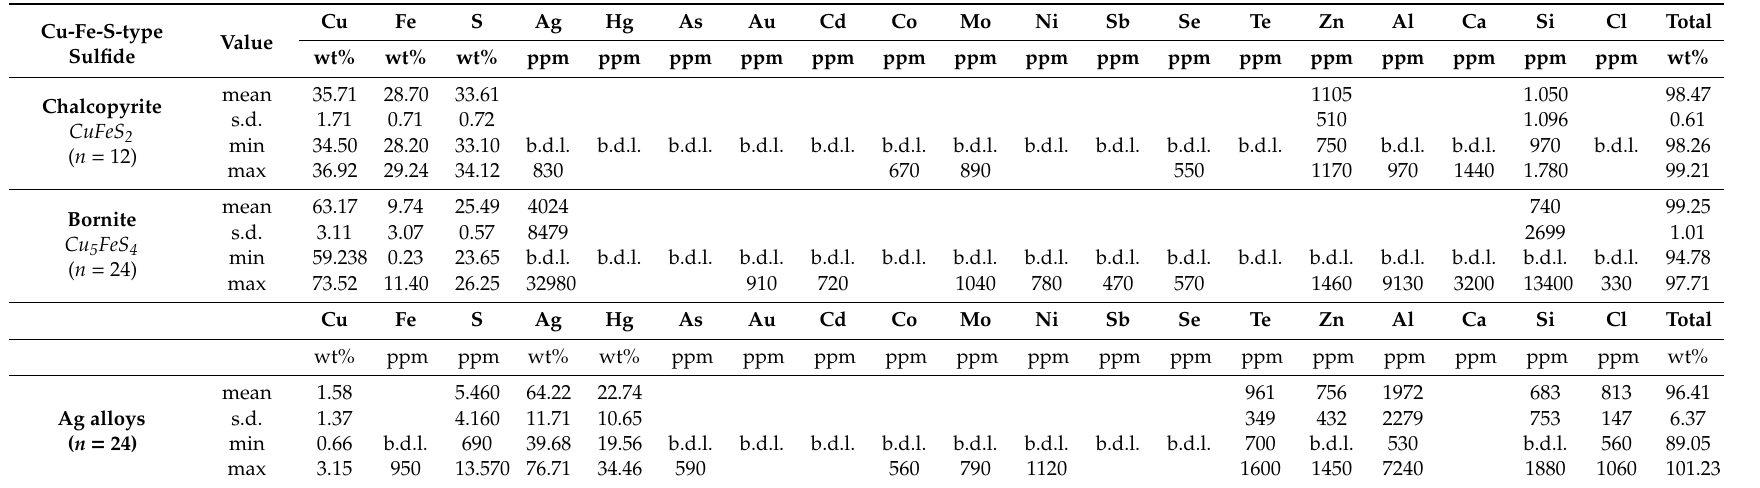
Table 10. Chemical composition of Cu-Fe-S-type sulfides and Ag alloys from the Cu-Ag Kupferschiefer deposits on the Fore-Sudetic Monocline identified by EPMA. Cu-Fe-S-type